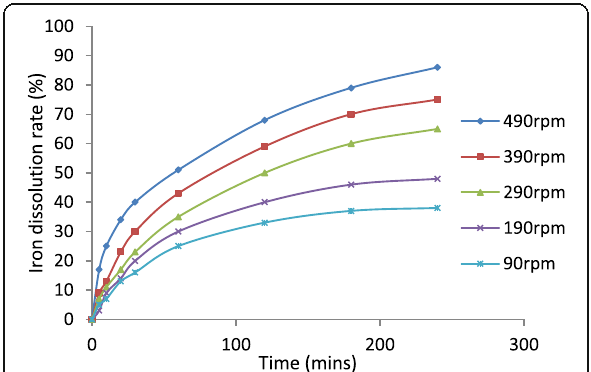
Fig. 2 Effects of agitation rates on the dissolution rate of Iron from Akwuke ore